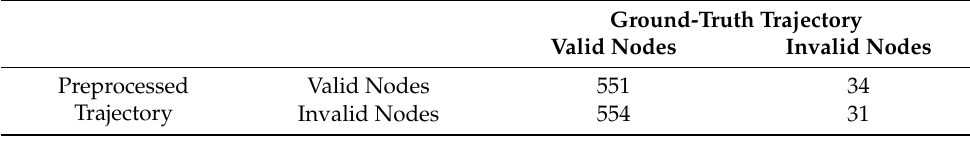
Table 5. Confusion matrix for preprocessing indoor trajectory method.